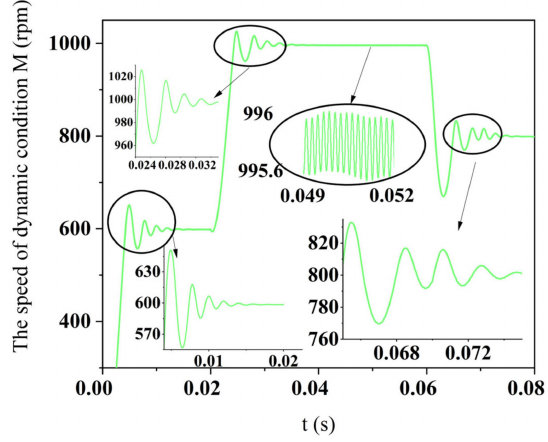
Figure 7. The speed of dynamic condition